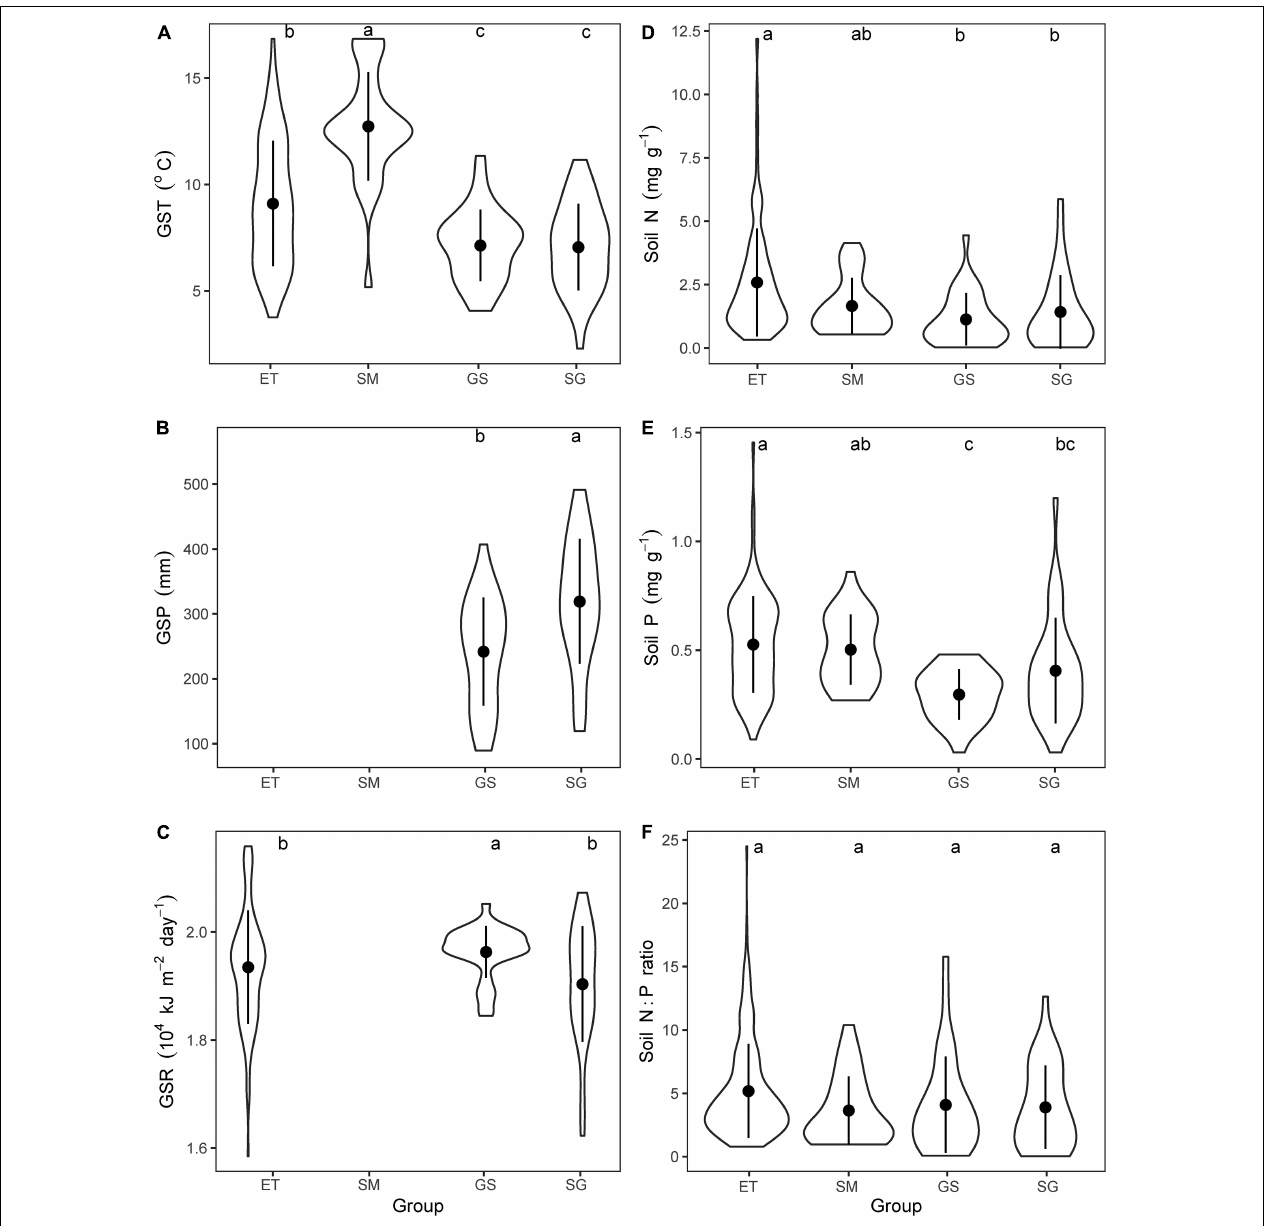
FIGURE 2 | Comparing the mean values of climatic variables and soil properties of nutrients. (A) Growing season mean air temperature (GST), (B) growing season precipitation, (C) growing season mean solar radiation, (D) soil total N contents, (E) soil total P contents, (F) soil N:P ratios for plots dominated by the four plant groups. ET, emergent plants, GS, grasses, SG, sedges, and SM, submerged plants. GSP for both emergent plants and submerged plants, and GSR for submerged plants were excluded. The lowercase letters on the top of each panel showed the results of Kruskal–Wallis test and Dunn’s Post Hoc Multiple Comparisons ( p <